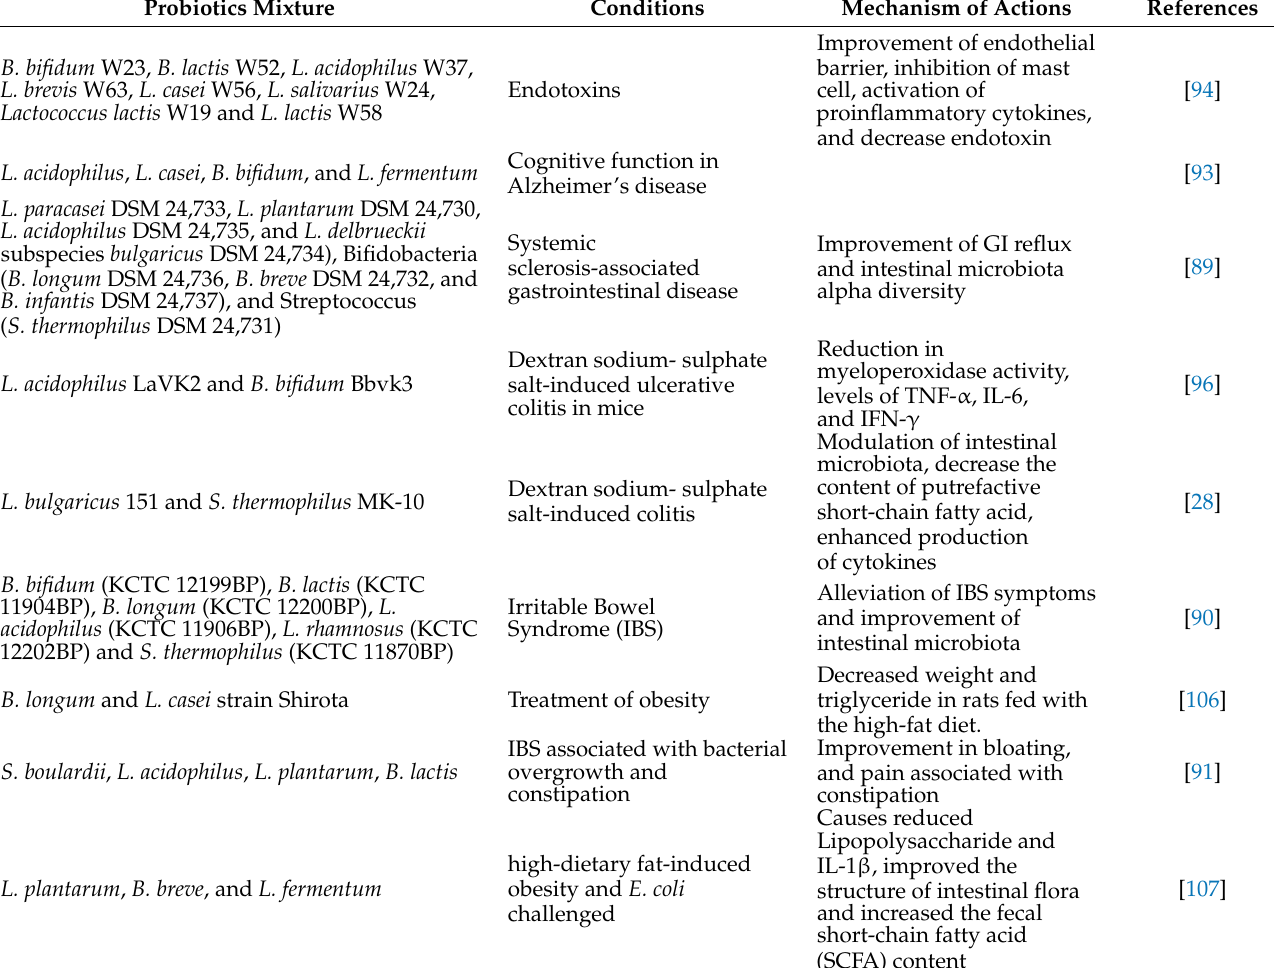
Table 1. The use of multi-strain probiotics in disease